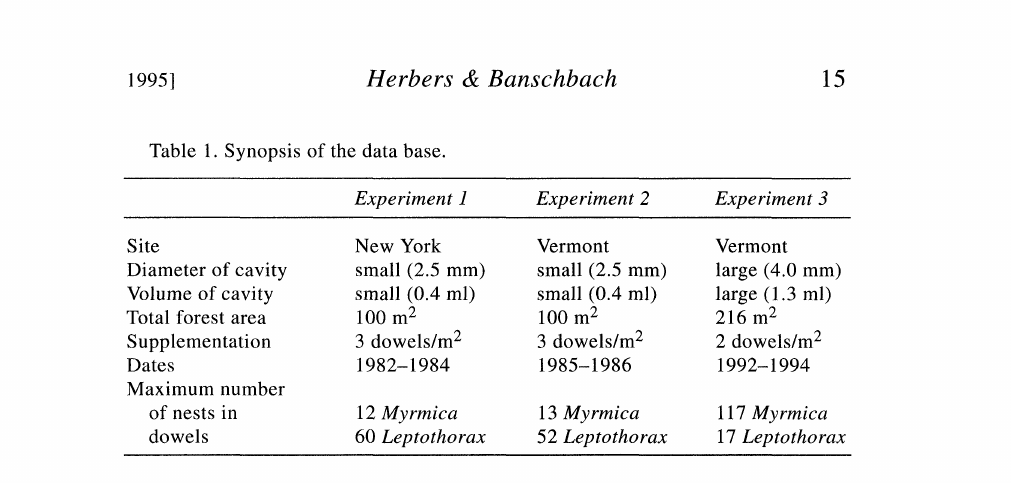
Table 1. Synopsis of the data base.